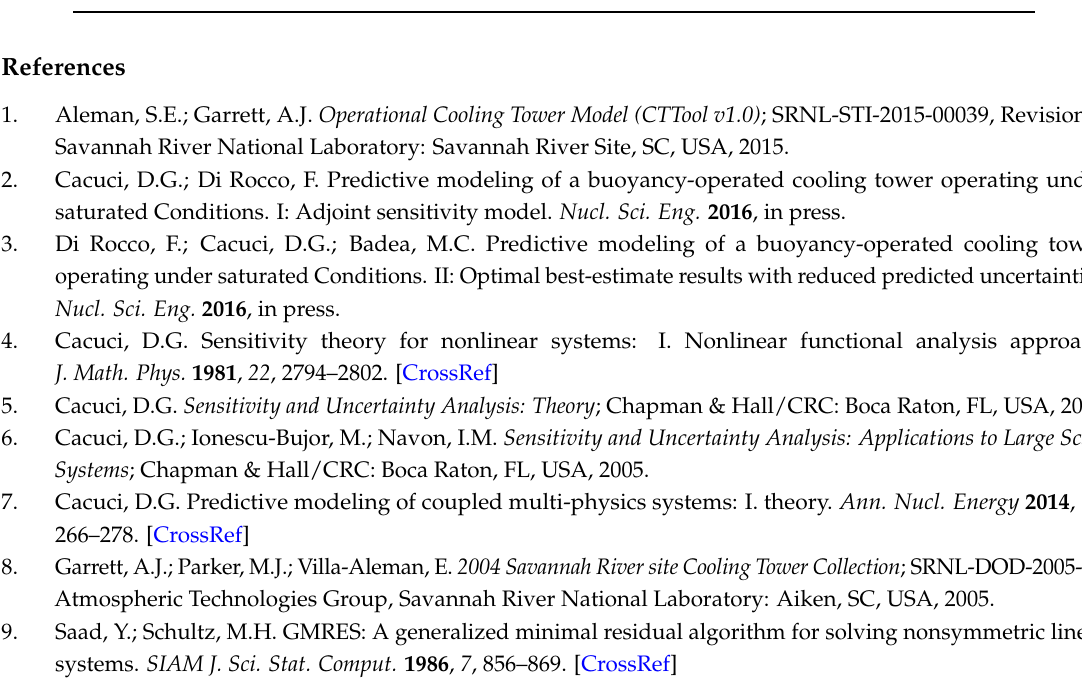
( 1 ) ( 50 ) ( 1 ) , a , T w , RH